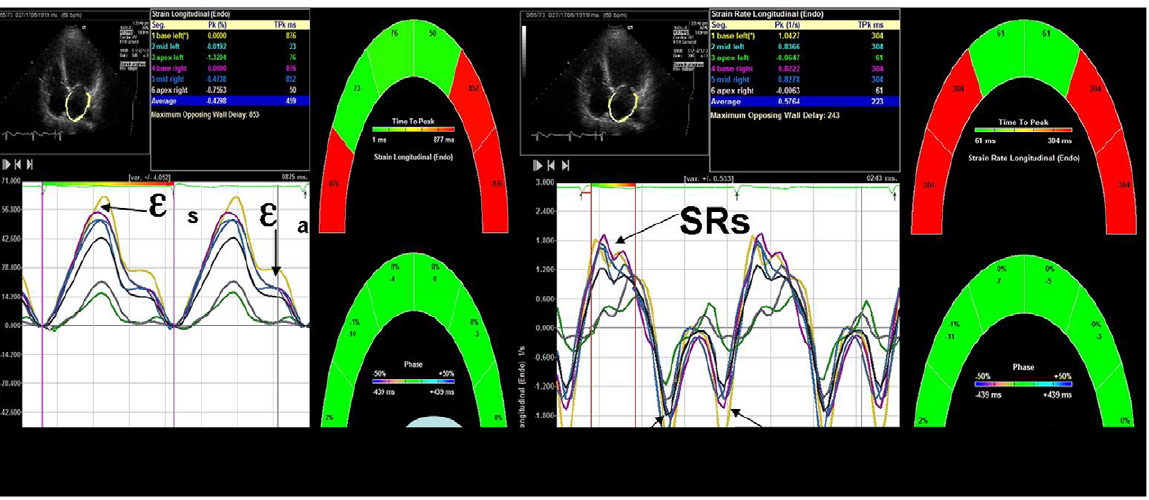
Figure 1. Left atrial longitudinal strain/strain rate curves obtained from an apical four-chamber view. e s : peak atrial longitudinal strain during ventricular systole, e a : atrial strain at the onset of P-wave on electrocardiography, SRs: peak left atrial strain during LV systole, SRe: peak left atrial strain during early LV diastole, SRa: peak left atrial strain during late LV diastole.